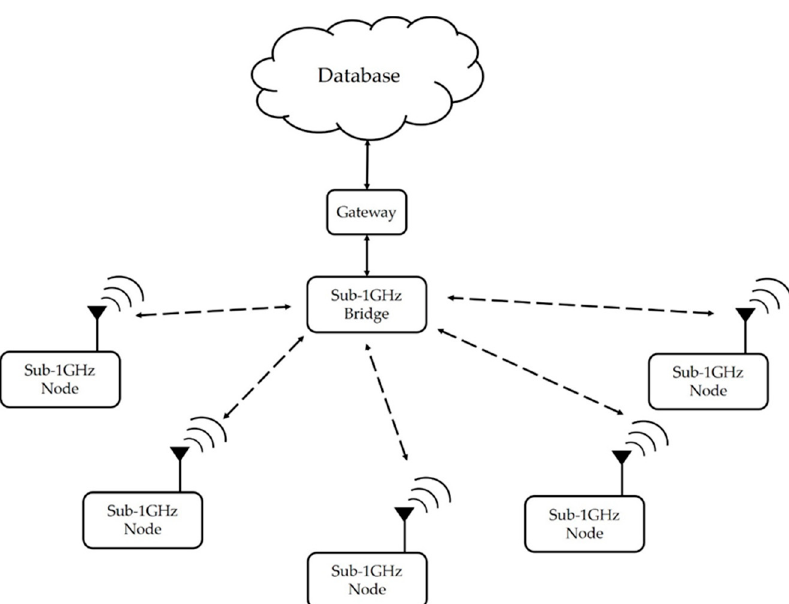
Figure 2. Star network architecture. Sensors 2020 , 20 , x